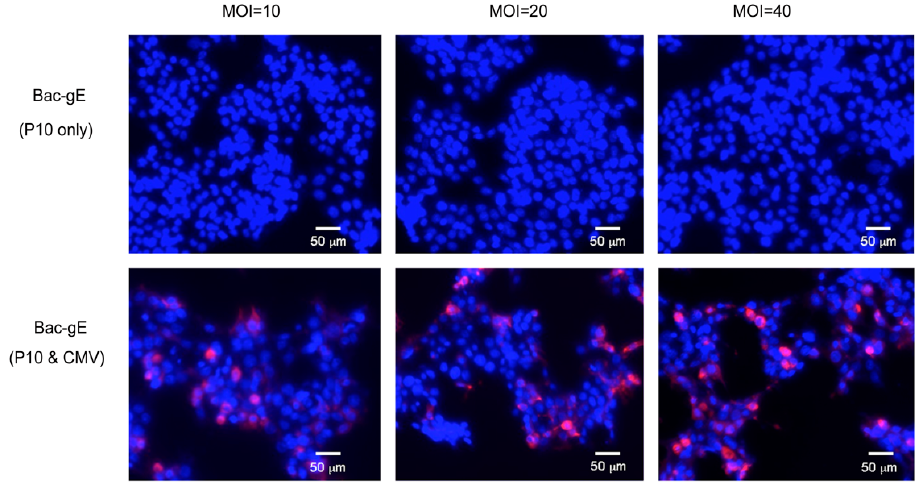
Figure 3. The expression of gE in mammalian cells was tested by transducing HepG2 cells with rBV Bac–gE (carrying P10 only or P10 and CMV promotors) at different multiplicity of infection (MOI). Red fluorescence suggests the expression of gE in HepG2 cells; blue fluorescence (DAPI) indicates the location of the nucleus (bar = 50 µm). Four technical replicates were performed during one ex- periment.